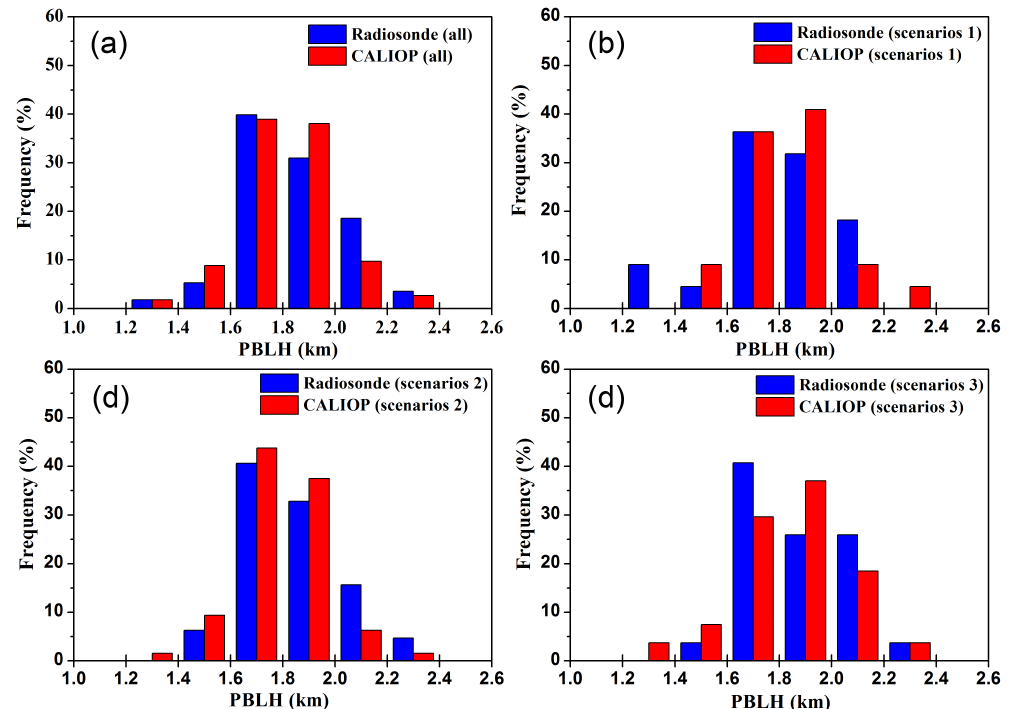
Figure 9. Histogram of the number of radiosonde sites stratified by binned radiosonde-derived mean PBLHs (blue bars, 14:00BJT) and CALIOP-derived mean PBLHs (red bar, around 13:30LT) over China in the summertime (June–July–August) during the period of 2011– 2014 for all radiosonde sites (a) and for the radiosonde sites belonging to scenario 1 (b) , scenario 2 (c) , and scenario 3 (d) . The frequency is calculated as the ratio of the number of radiosonde site in each PBLH bin to the total number of radiosonde sites. Note that the statistic results are only limited to the samples with collocated CALIOP- and radiosonde-derived PBLHs.